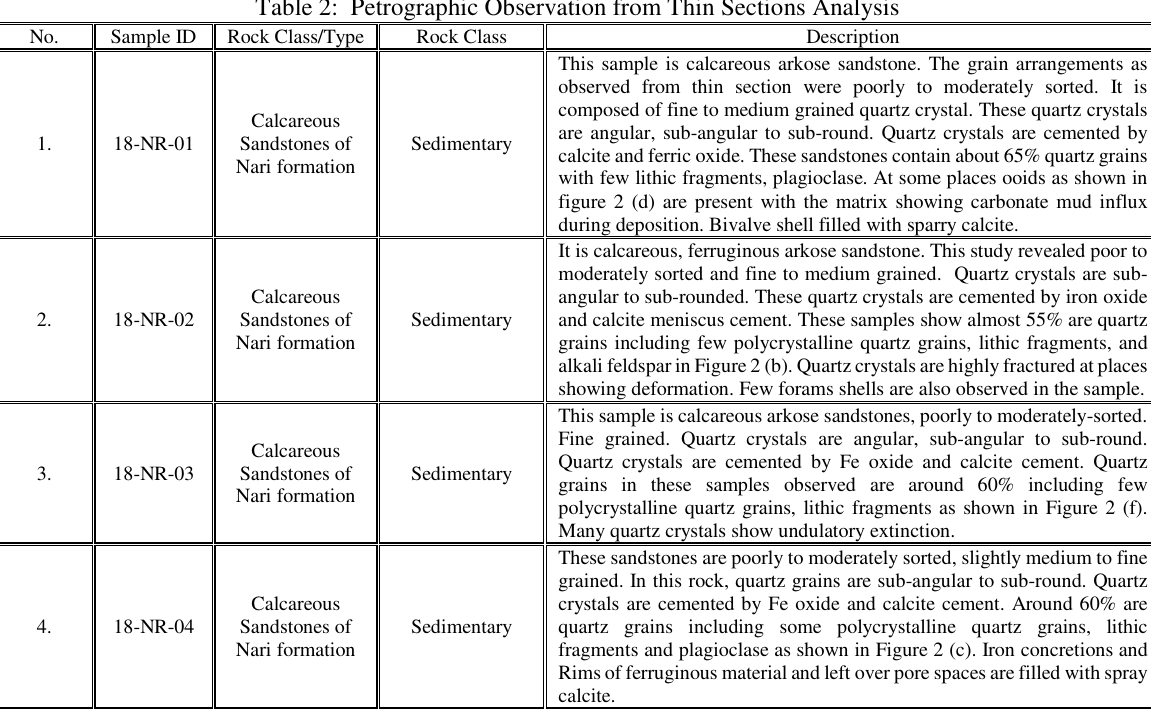
Table 2: Petrographic Observation from Thin Sections Analysis